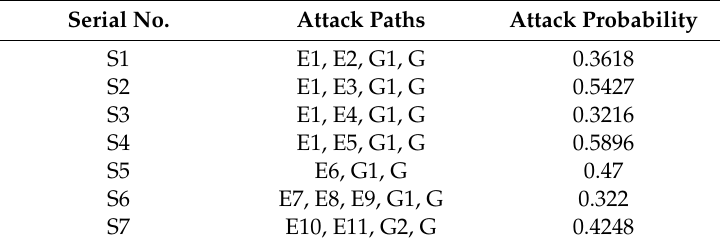
Table 4. Results of the calculation of the attack path